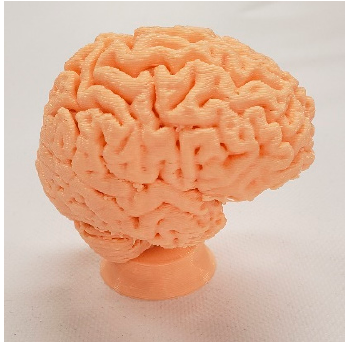
Figure 1. Human brain model [66].